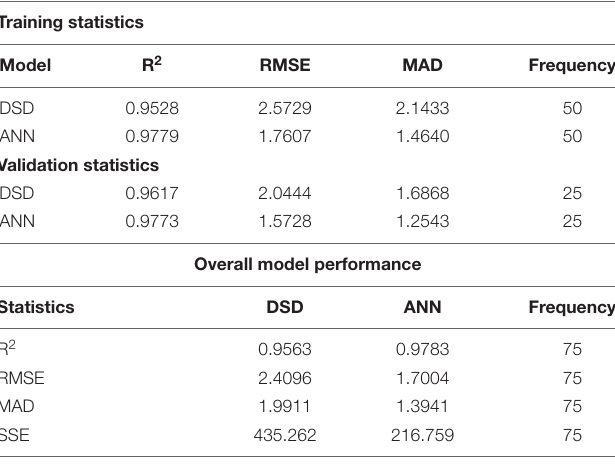
TABLE 3 | Comparison statistics of the model operation established by DSD and ANN for Co (II) bioremoval by P. alcaliphila. Training